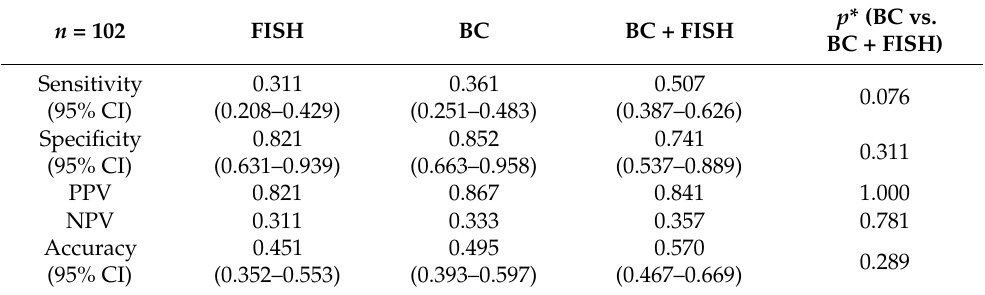
p * (BC vs. BC + FISH)